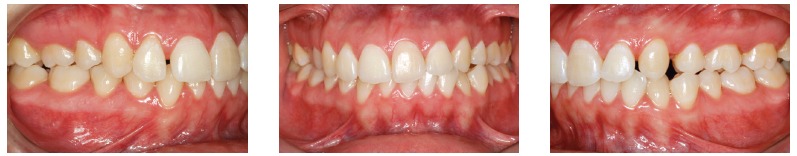
Photographs of clinical conditions at the beginning of treatment.